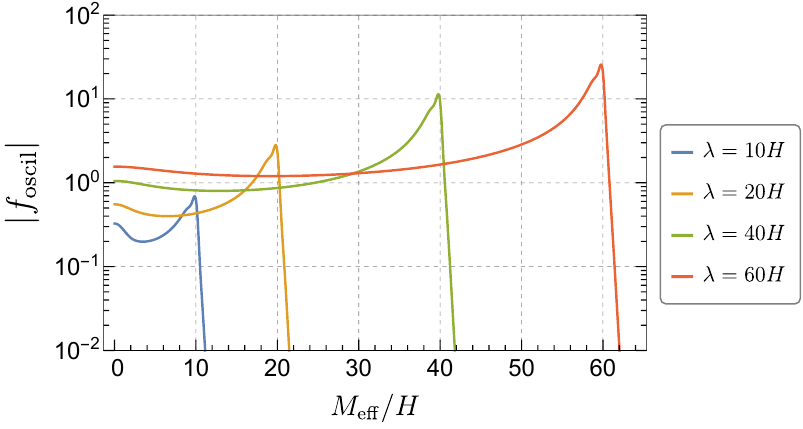
Figure 3. Amplitude of the non-analytic contribution | f oscil | from the full calculation in ap- pendix B, plotted against the physical mass M of the complex scalar in Hubble units for c = 0 . 5 eff and various values of the chemical potential λ = 10 H (blue), 20 H (yellow), 40 H (green), and 60 H (red). We take α/ Λ = 0 . 1 λ . The expression for NG has a subdominant dependence on the param- eter c , and hence we only show a representative plot for a generic value c = 0 . 5 . Note that the range 0 < M . λ corresponds to − λ 2 / 2 < M 2 . λ 2 / 2 for the “bare” mass. The tachyonic regime eff for M (as opposed to M ), M 2 < 0 , corresponds to a post-inflationary instability to generating eff a significant χ VEV. During inflation, this instability is absent in the regime of non-tachyonic de Sitter mass M plotted. No fine-tuning of parameters is needed to obtain the large signals shown. eff